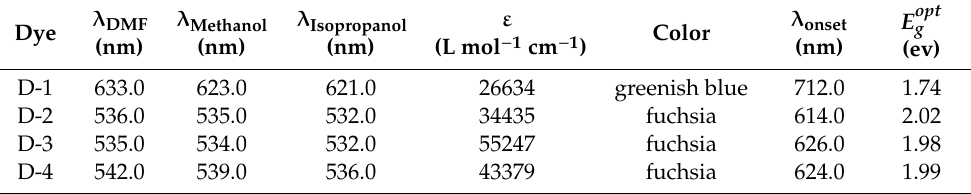
Table 1. Spectroscopic properties of the azo heterocycle reactive dyes.